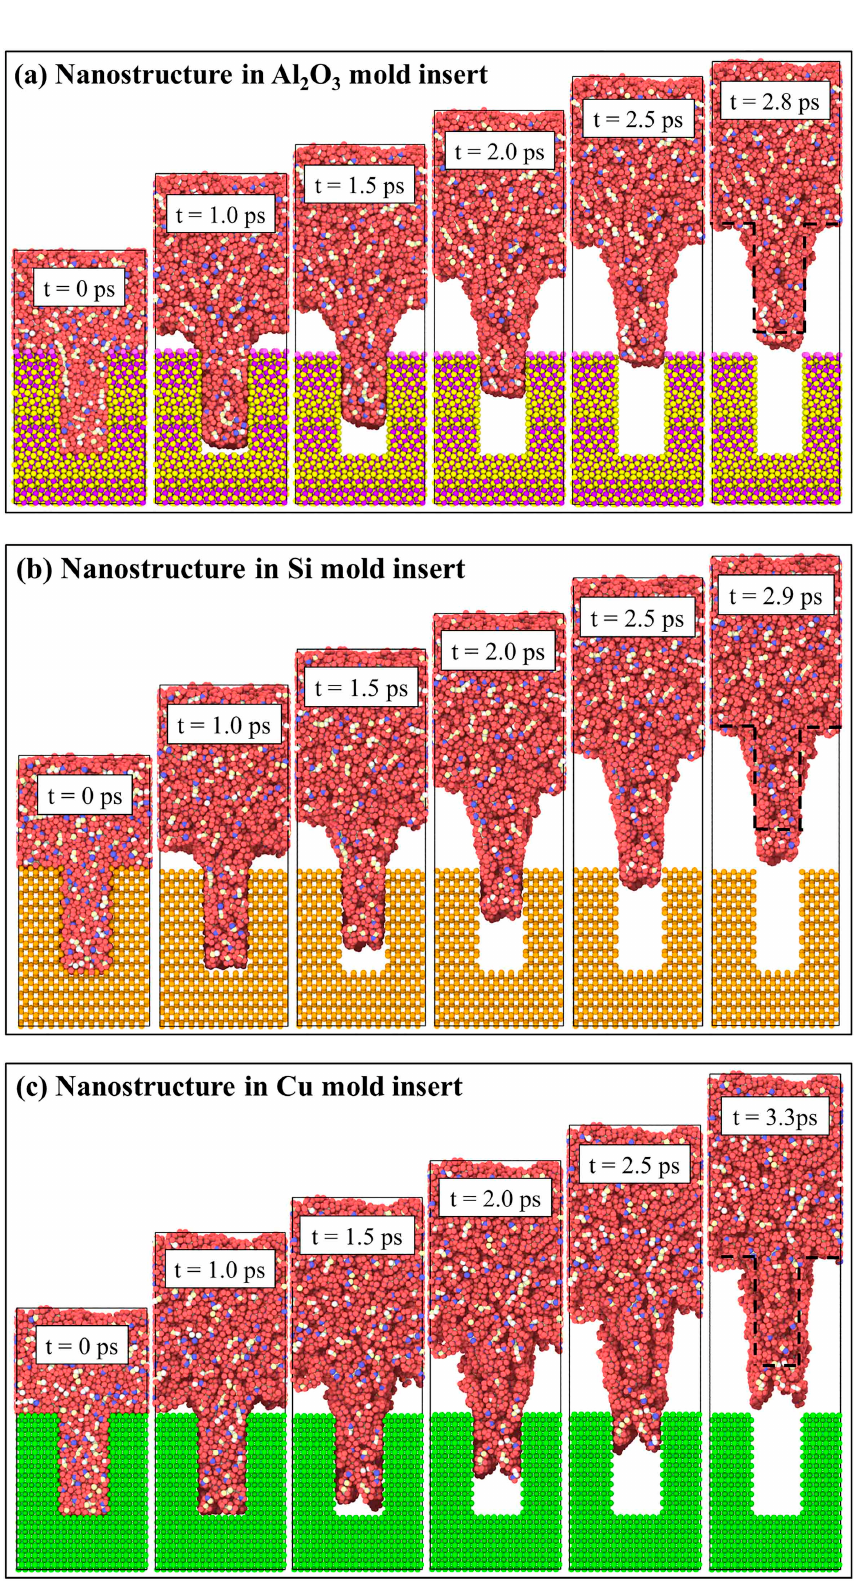
Figure 8. Snapshots of demolding processes of rectangular nanostructures with different mold insert materials: ( a ) Nanostructure in Al 2 O 3 mold insert, ( b ) nanostructure in Si mold insert, ( c ) nanostructure in Cu mold insert.